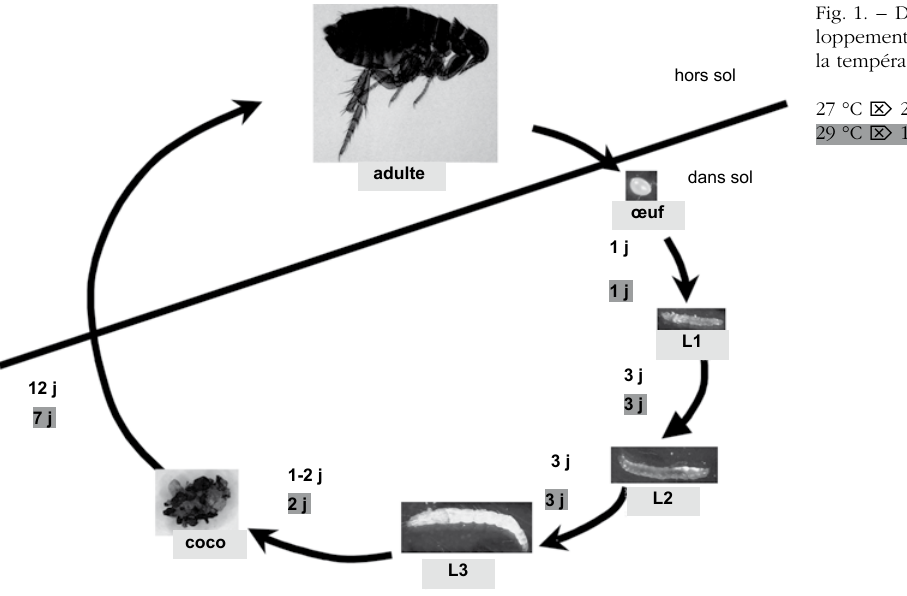
Fig. 1. – Durée minimale du cycle de déve- loppement de C. f. strongylus en fonction de la